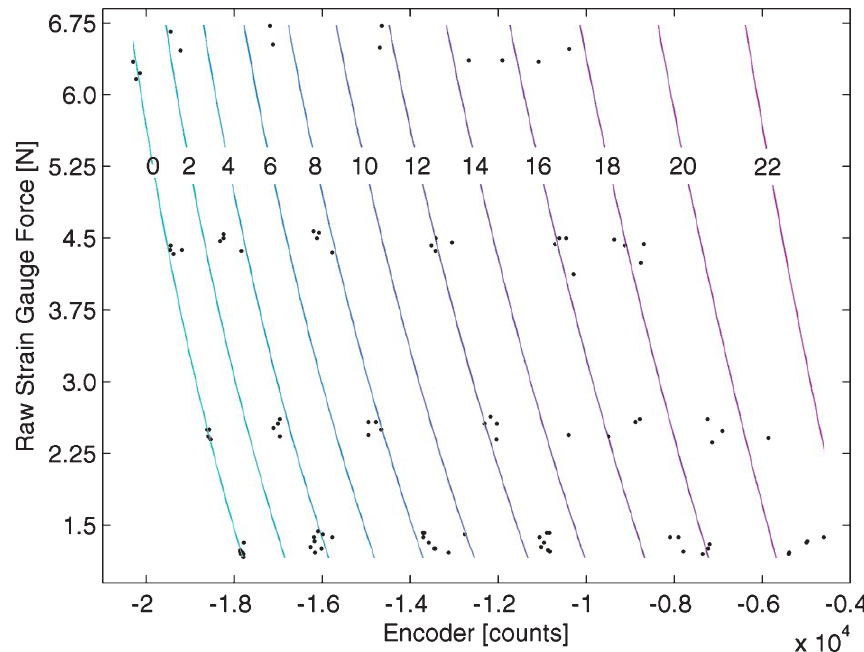
Fig. 8. Contour plot showing the actual position of the jaws as the measured force and encoder counts are varied. The contours give the position of the jaws in mm. The difference between the contours and observed data points is due to the compliance of the cardboard